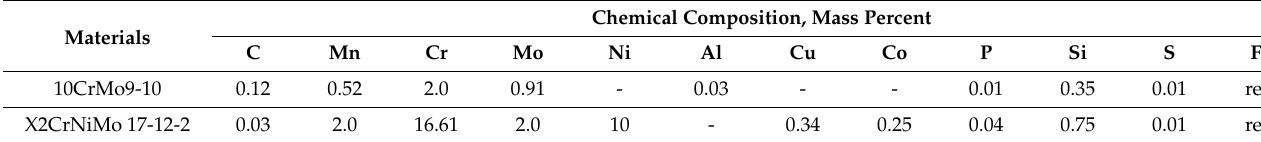
Table 1. Chemical composition of the tested materials 10CrMo9-10 and X2CrNiMo17-12-2.